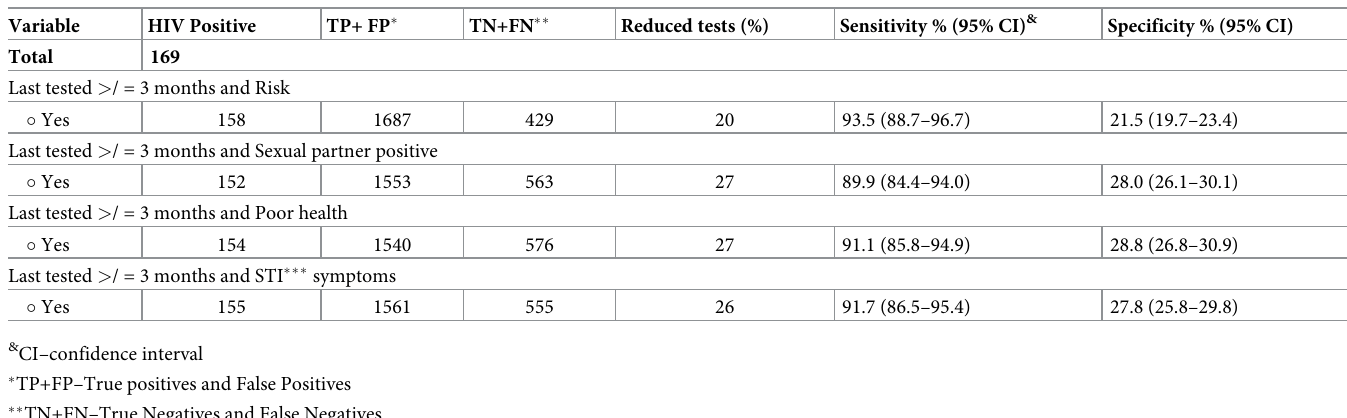
Table 8. Sensitivity and specificity for inclusion criteria combinations for HIV testing services screening questions, Zimbabwe, 2021. (N = 2116). Variable